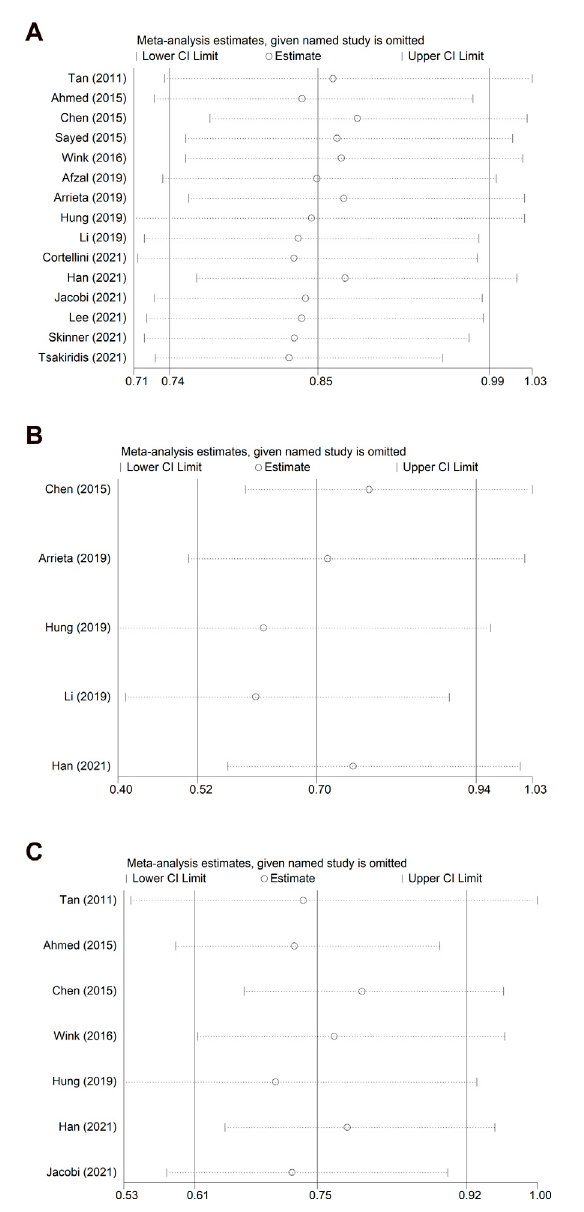
FIGURE 5 Sensitivity analysis for the association between metformin use and progression-free survival in (A) all NSCLC patients; (B) patients receiving EGFR-TKI therapy; and (C) patients with diabetes mellitus. NSCLC:non-smallcelllungcancer;EGFR-TKI:epidermalgrowth factor receptor-tyrosine kinase